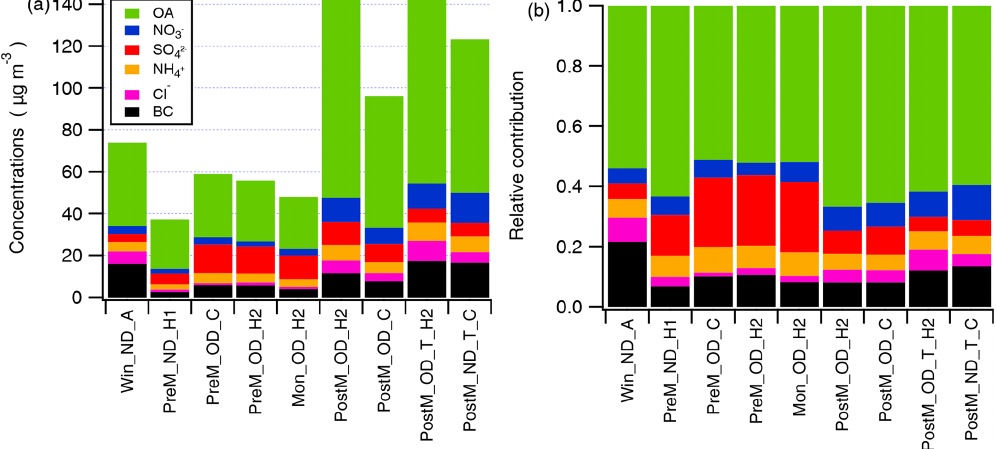
Figure 2. Average aerosol concentrations (a) and relative contribution to C-PM 1 (b) .